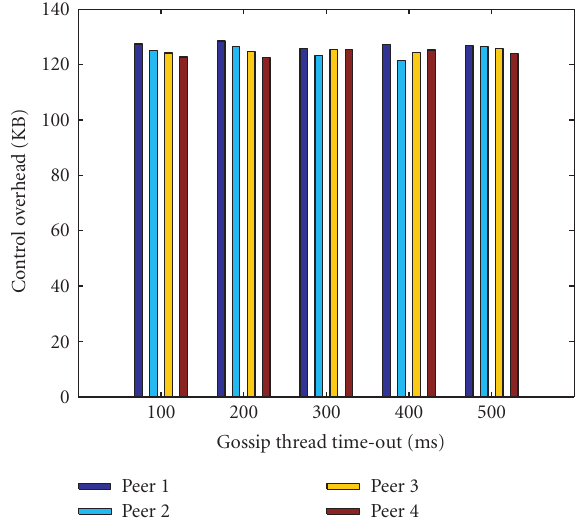
Figure 12: Time to download versus gossip thread time-out.